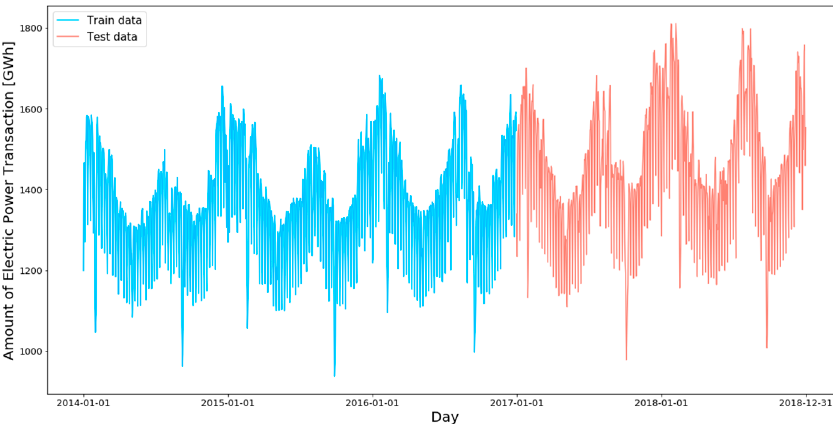
Figure 15. Composition between training data and test data.